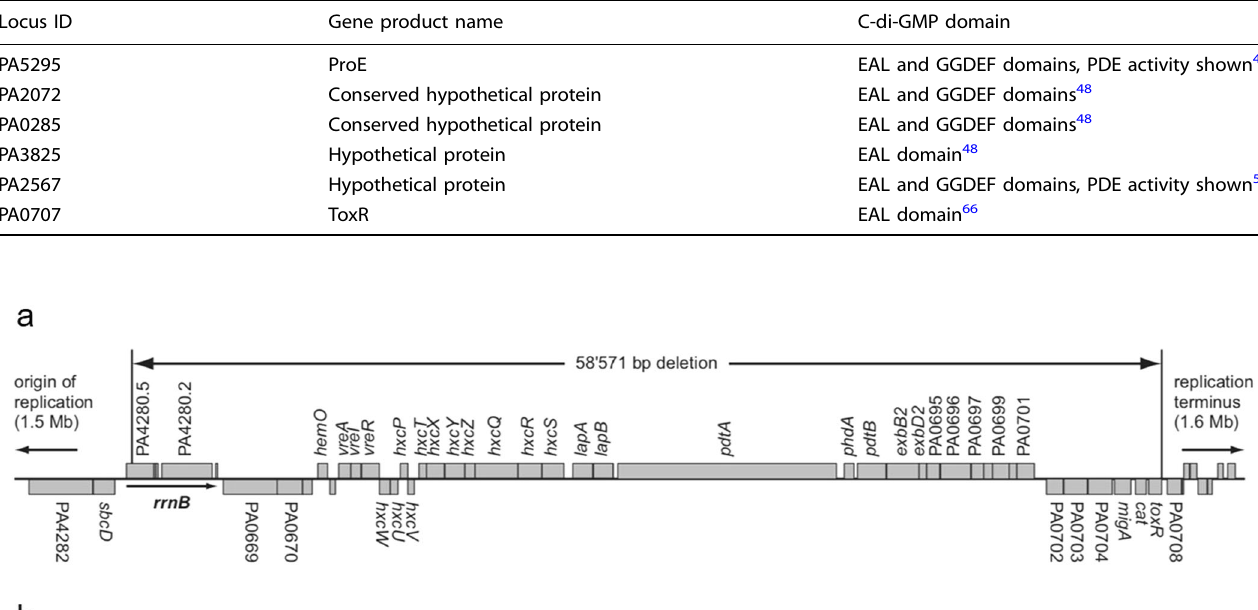
Table 1. Genetic elements with conserved domains from the family of proteins involved in c-di-GMP metabolism that restored swarming motility in PAO1-N Δ rsmA